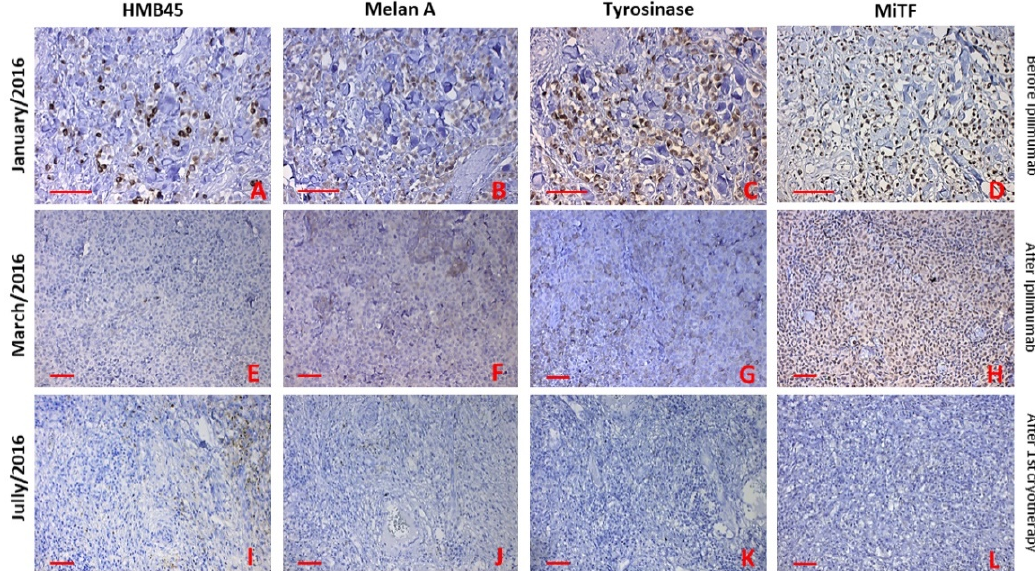
Figure 4. Immunohistochemical staining was performed to compare the phenotype of skin metastases, before initiation of ipilimumab therapy, after the last dose and after the first cryotherapy. The expression of all markers (HMB45, Melan A, Tyrosinase and MiTF) were present before initiation of ipilimumab therapy ( A – D ). MiTF and tyrosinase were only positive after the last dose of ipilimumab ( G , H ). HMB45 and Melan A were negative ( E , F ). Only HMB45 was positive in some melanoma cells at the edge of the necrotic tissue ( I ). Other markers were negative ( J – L ). Bar 50 µ